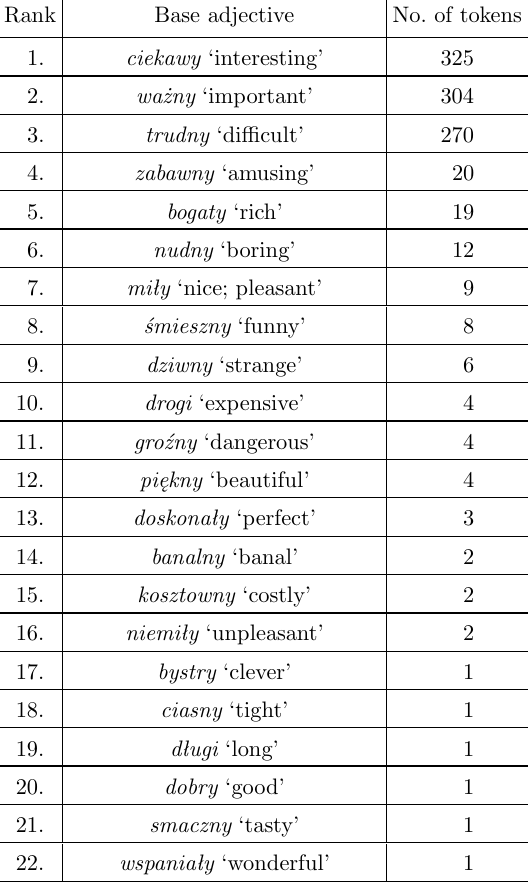
Adjectival bases reinforced by arcy - in the NKJP